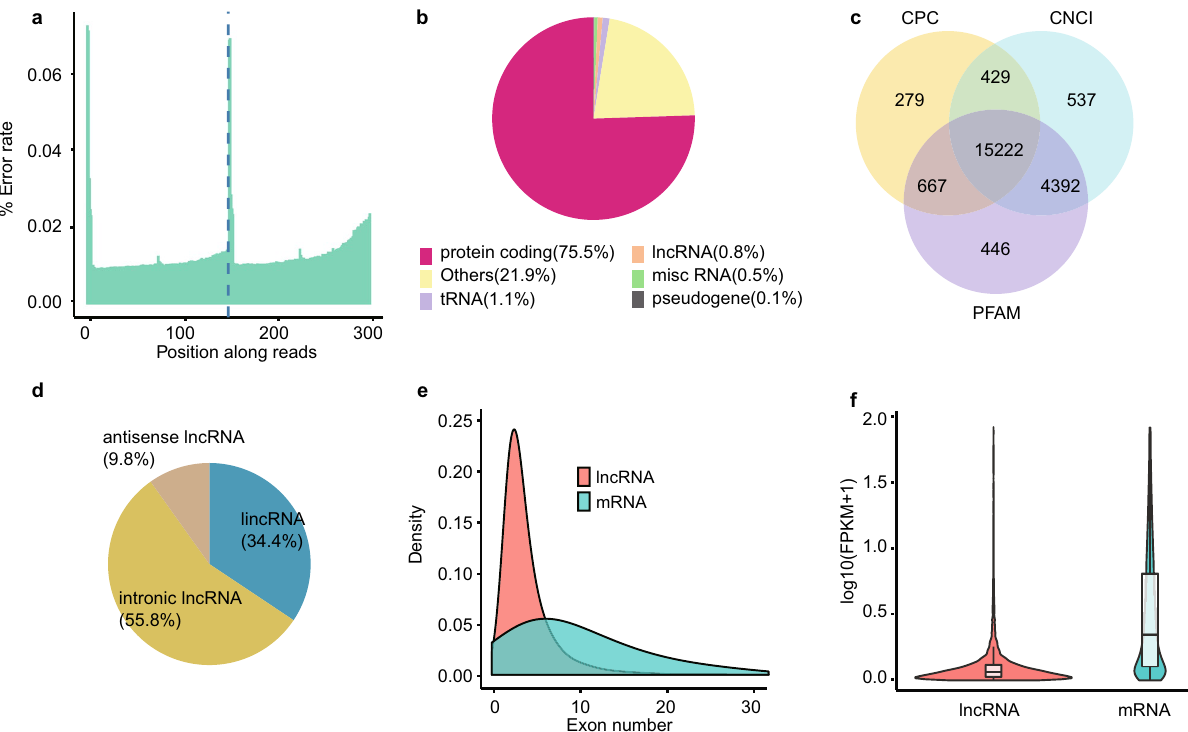
Figure 1. Analyses of mRNA and lncRNA from RNA-seq data. ( a ) Sequencing error rates of read base positions from 1 to 300 bp. ( b ) Percentages of protein coding RNA, lncRNA, misc RNA, rTNA, pseudogene and other classifications for all the mapped reads. ( c ) Comparisons of candidate lncRNAs identified by CPC, CNCI and PFAM. ( d ) Proportions of three lncRNA classifications of lincRNA, antisense lncRNA and intronic lncRNA. ( e ) Density distributions of exon number for both mRNA and lncRNA. ( f ) FPKM distribution of both lncRNA and